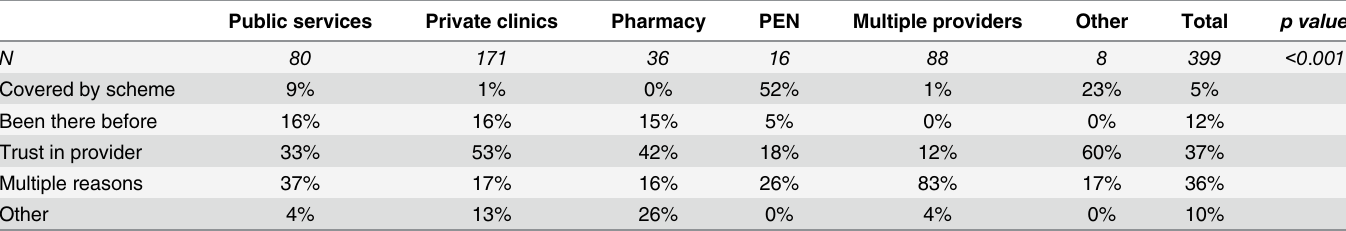
Table 4. Reason for choosing provider.